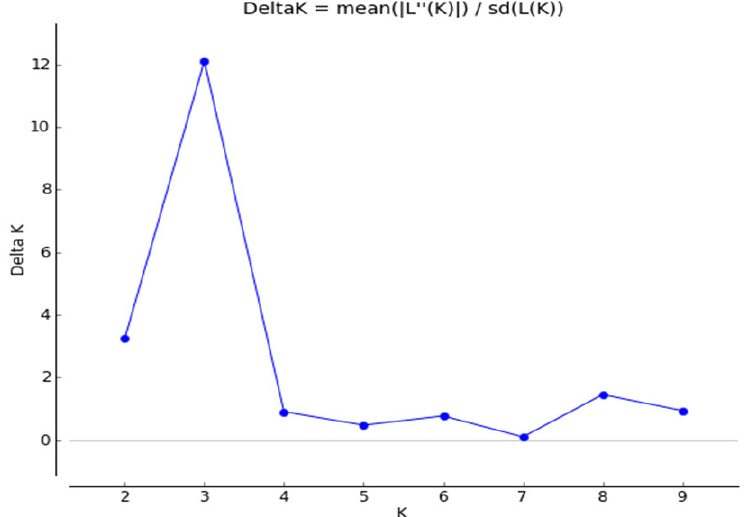
Figure 2. The STRUCTURE estimation of the number of populations for K values ranging from 1 to 10. The K value with the highest delta K represents the suggested cluster number.